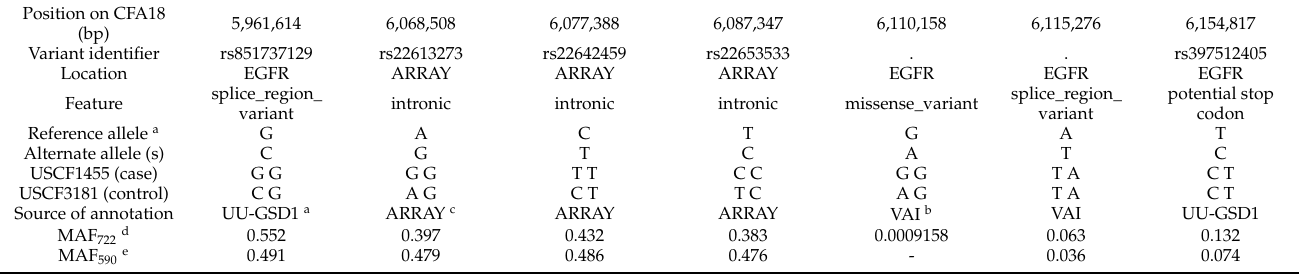
Table 1. Characteristics of putative protein-coding variants and array markers on